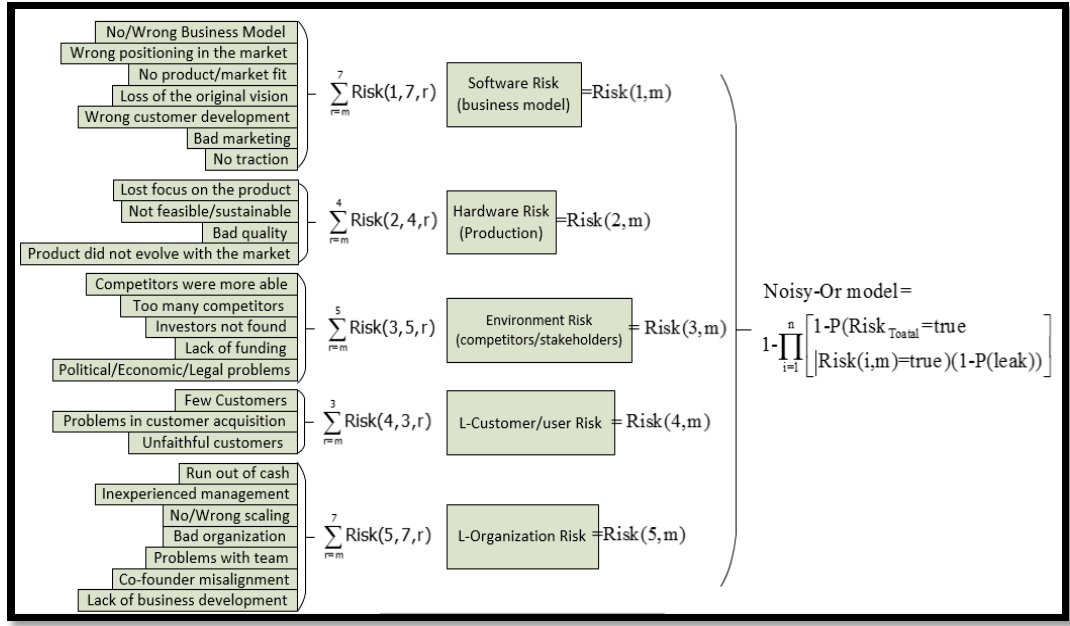
Figure 4. Relationships between the main risks and the overall risk of start-up .